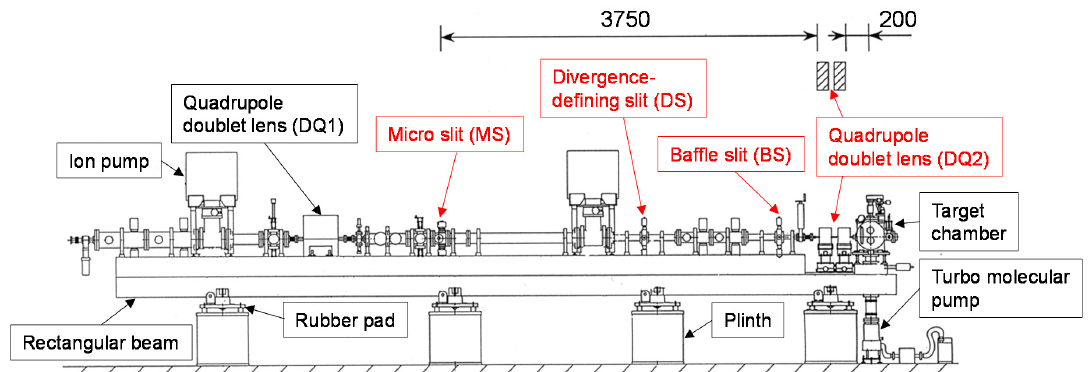
Figure 15. An illustration showing the configuration of the heavy-ion microbeam